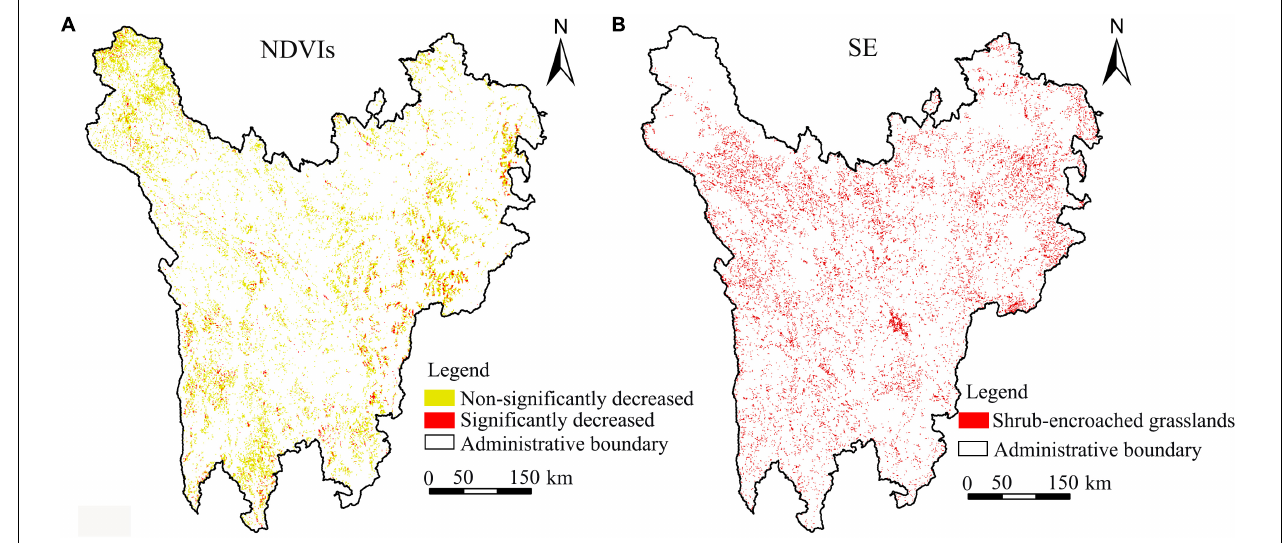
FIGURE 5 | Grassland degradation from 2005 to 2018. (A) NDVIs, slope of NDVI change. (B) SE, shrub-encroached